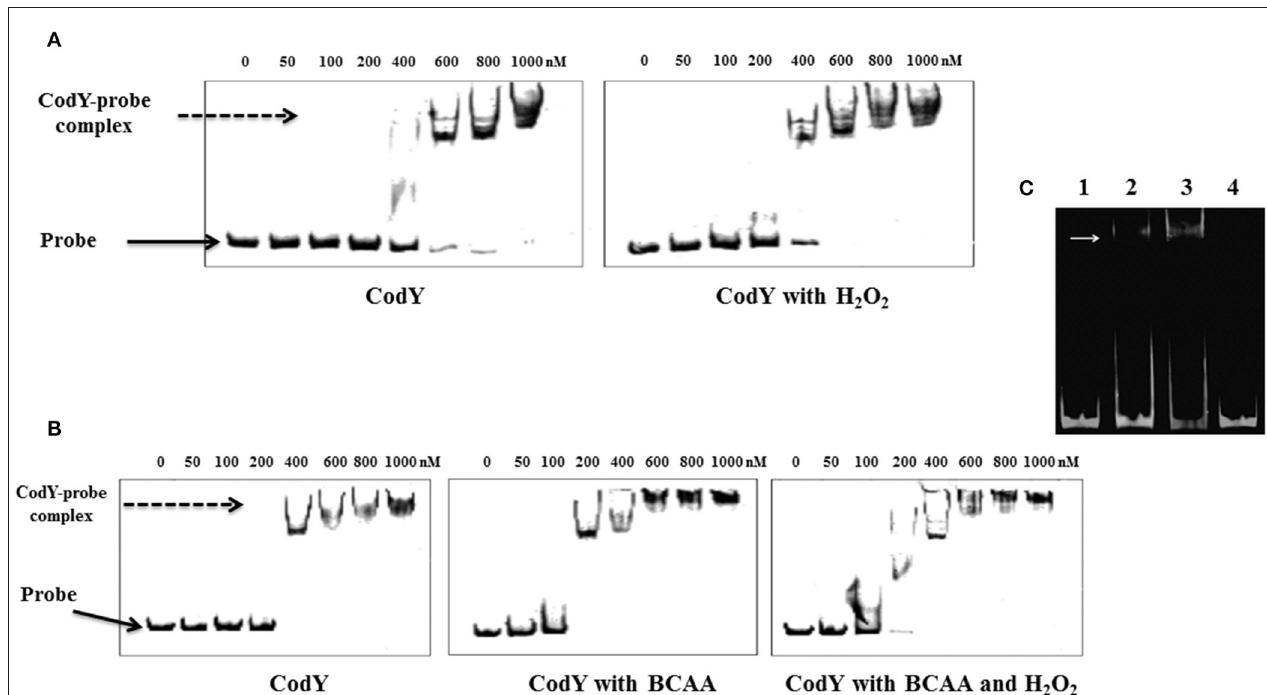
FIGURE 4 | CodY interaction with the regulatory region of tpxD. EMSA assay was used to confirm the presence of CodY binding site in tpxD regulatory region: Effect of H 2 O 2 (A) and BCAA (B) . 10 nM of fluorescently labeled DNA probe was mixed with increasing concentration of recombinant CodY, and incubated for 30 min at room temperature. When required, 2 mM H 2 O 2 and/or BCAA (isoleucine 1.62 mM, leucine 3.48 mM, and valine 2.77 mM) were added into the binding buffer. DNA-protein complexes were separated by electrophoresis on non-denaturing PAGE (8%). In all gels, Lane 1 contains DNA probe alone, indicated with a black arrow. DNA-protein interaction is seen as an upward shift of DNA probe, indicated with a dotted arrow. (C) Lane 1, 50 ng approximately of the 81 bp DNA fragment alone, lane 2 and 3, DNA plus 0.6- and 1-mM recombinant CodY, respectively. Lane 4, DNA probe, excluding 15 bp putative CodY binding site plus 1 mM recombinant CodY. White arrow indicates the position of DNA-protein complex. EMSA was performed using Molecular Probes fluorescence-based EMSA kit (Invitrogen). Briefly, 5X FY binding buffer (20 mM Tris-HCl pH 7.5, 30 mM KCl, 1 mM DTT, 1 mM EDTA pH 8.0 and 10% v/v glycerol) was prepared to incubate the promoter probe and protein. The binding reaction was set up by mixing a constant amount of target promoter probe ( ∼ 30 ng), and increasing amounts (0.1–0.5 µ M) of purified